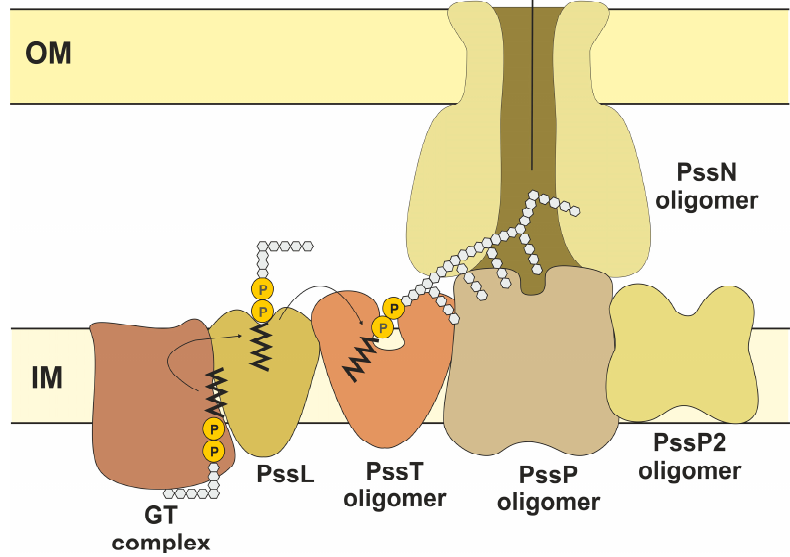
Figure 3. The proposed model of topology of the EPS transport system in R. leguminosarum bv. trifolii . The model is the result of a compilation of available data concerning the key proteins operating in the Wzx/Wzy-transport system and experimental data from the R. leguminosarum bv. trifolii model. Exopolysaccharide octasaccharide subunits are assembled on a lipid carrier by glycosyltransferases. Glycosyltransferases are shown as a single block, which presupposes the existence of a complex, although not apparent from the available experimental data. Exopolysaccharide octasaccharides are translocated to the outer leaflet of the IM (Inner Membrane) and PssL is proposed to serve this function. Subunits are then polymerized due to the concerted action of PssT polymerase and oligomeric PssP co-polymerase. Synthesis and transport proteins interact in a complex network, where the most prominent interactions involve: PssT-PssP and PssP-PssN. PssP2 protein is encoded within the Pss-II region, but was also shown to influence the length of EPS polymers and interact with PssP and PssT. OM: Outer membrane.